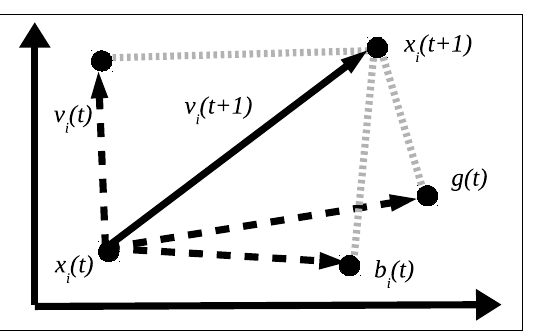
Figure 2. Movement of particle i in a two-dimensional search space. The particle, which is currently at position x i ( t ) , will move to a new position, x i ( t + 1 ) , taking into account its new velocity, v i ( t + 1 ) .